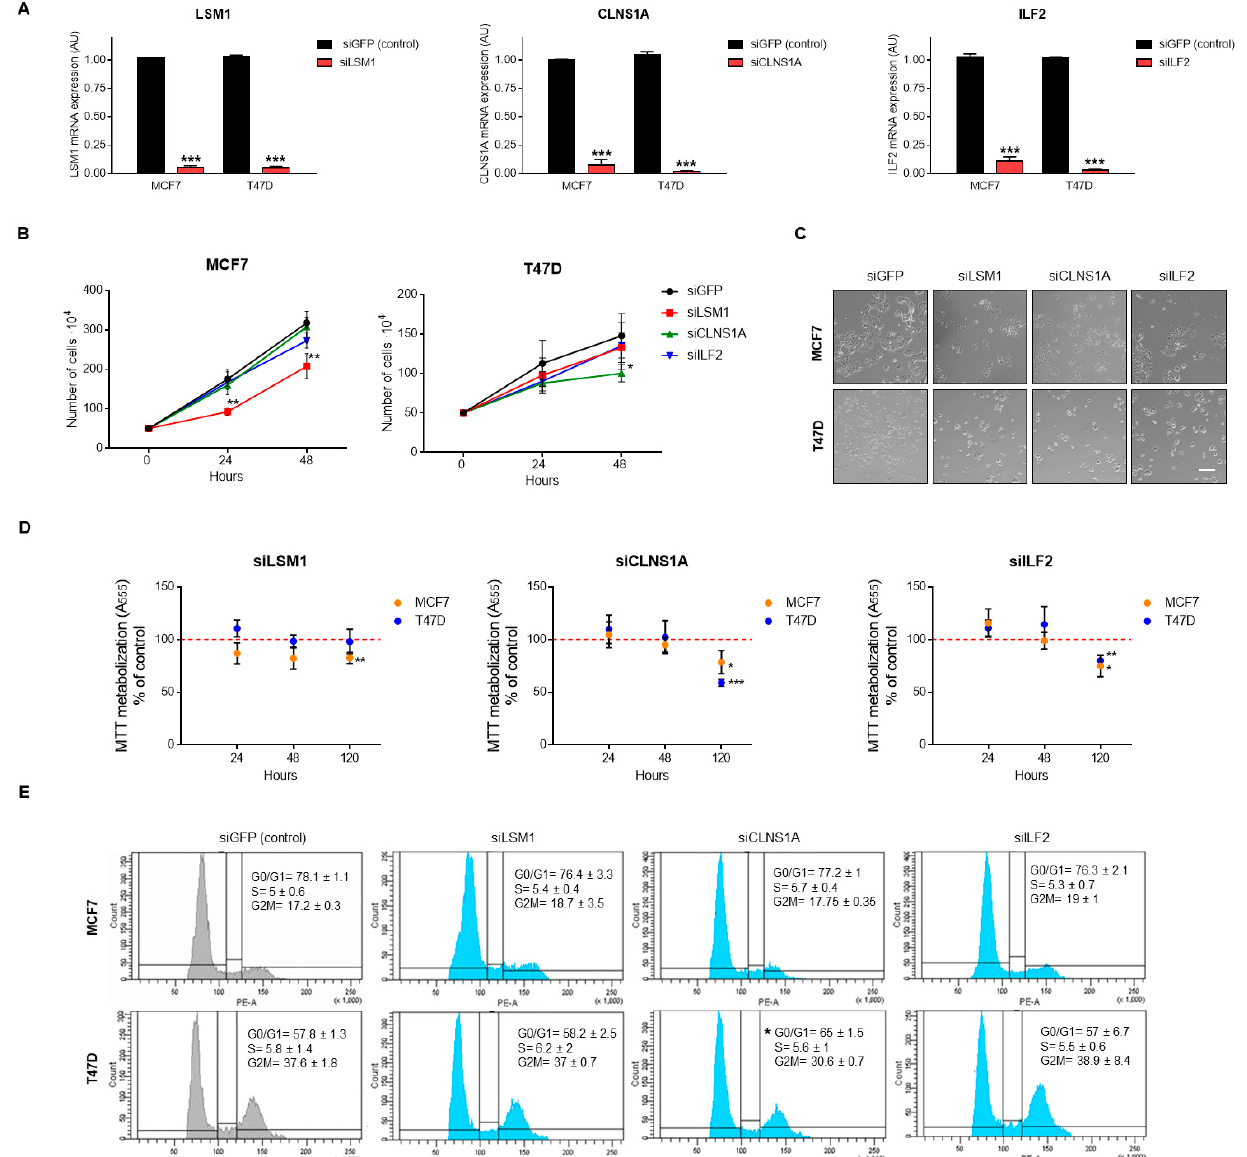
Figure 5. Splicing-related genes genomic inhibition by siRNA and pharmacological inhibition by BET inhibitor and PROTAC. ( A ). LSM1 , CLNS1A, and ILF2 mRNA expression in MCF7 and T47D luminal A breasts cancer cells after transfection with siRNAs. Cells were transfected using lipofectamine reagent and 24 h later were reseeded. After 24 h, (48 h post-transfection), cells were collected, RNA was extracted, and qPCR was performed. siGFP was used as the control of transfection. ( B ). Transfected cells were seeded (50,000 cells 6-well plate and were counted after 24, 48 and 120 h). ( C ). Images obtained by inverted microscope of transfected cells after 48 h. ( D ). Antiproliferative effect of siRNA evaluated by MTT assays after 24, 48, and 120 h. ( E ). Changes in cell cycle phases after genomic inhibition (representative plot of two independent experiments is shown). Scale bar = 100 μ m. * p < 0.05; ** p < 0.01; *** p < 0.001.